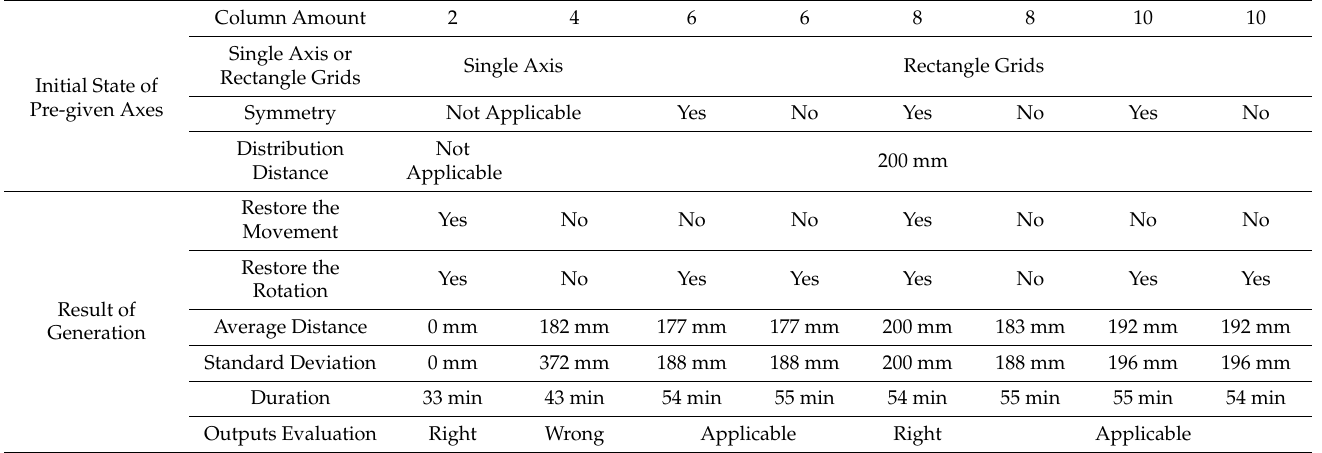
Table 1. The statistics of pre-given axes and generated